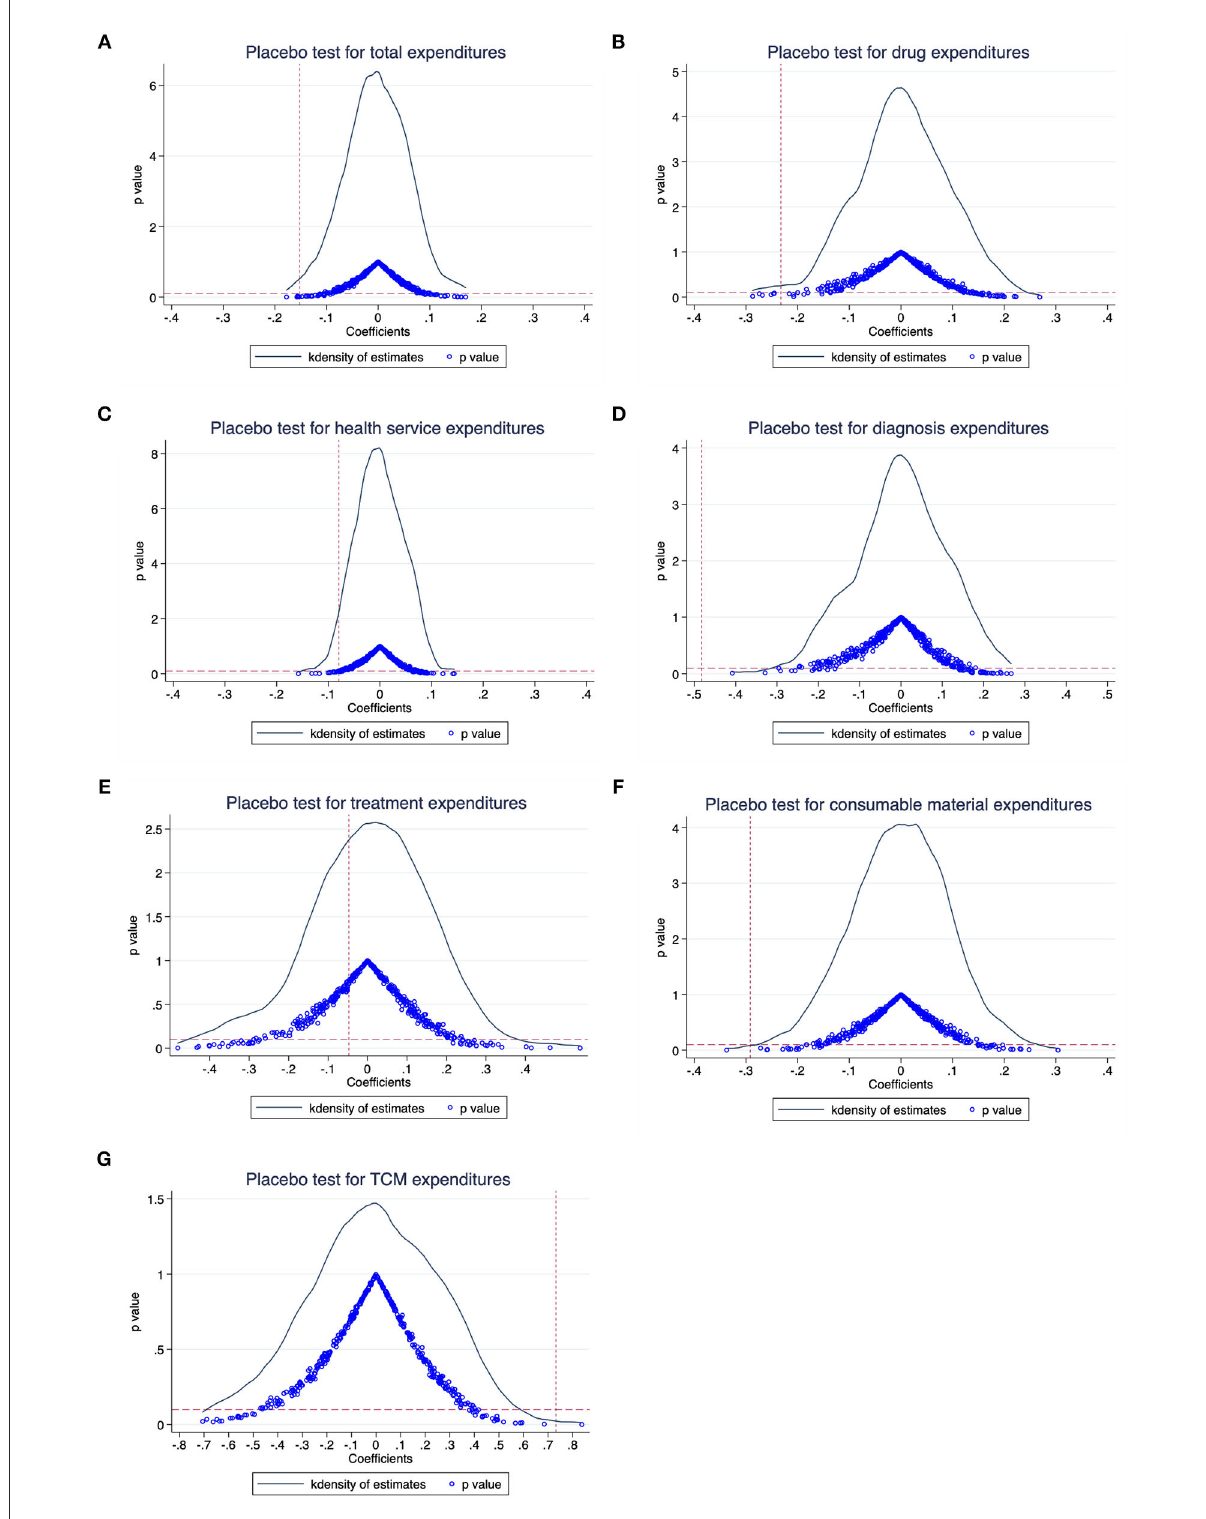
FIGURE3 Placebo test results: The distribution diagrams of the coefficients. (A) Total expenditures, (B) drug expenditures, (C) health service expenditures, (D) diagnosis expenditures, (E) treatment expenditures, (F) consumable material expenditures, and (G) TCM